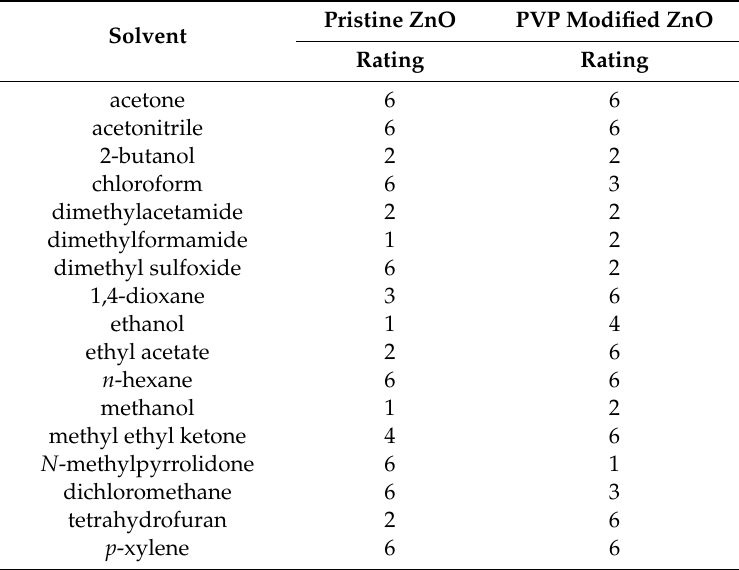
Table 4. Rating of di ff erent solvents as dispersants for pristine and PVP-modified ZnO nanoparticles (for criteria see Table 1).